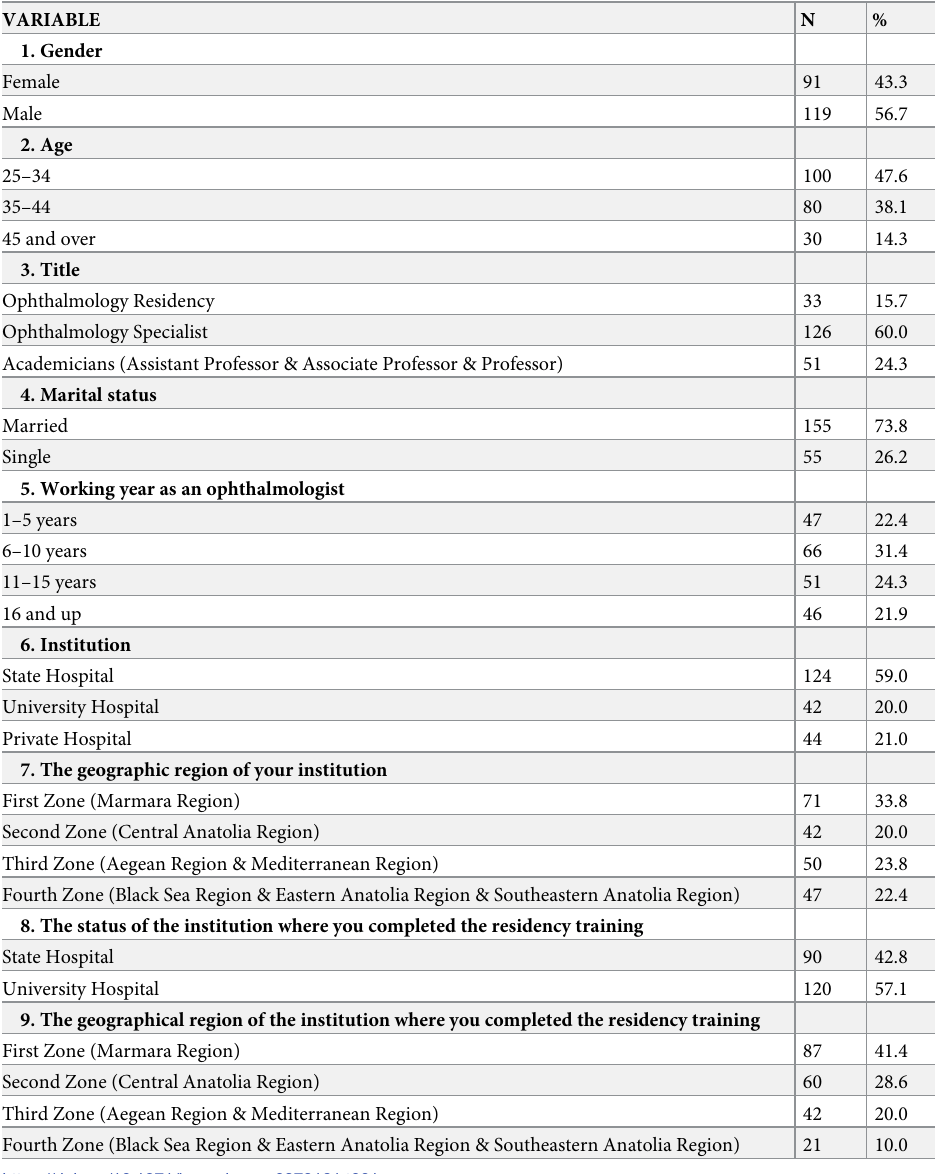
Table 1. Demographic characteristics of the